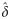
Simulation of a group of populations where the true dispersal rate (δ) is assumed fixed and independent of the true population density (De).A. Relationship between log(b) and log(De) when De is measured without error. B. Single realisation of the same relationship when De is measured with error. C. Single realisation of the relationship between log(δ^) and log(D^e) when De is measured with error. To generate further realisations of the process, and to explore the effect of changing the error in the estimate of De, see Table A in S2 Table.